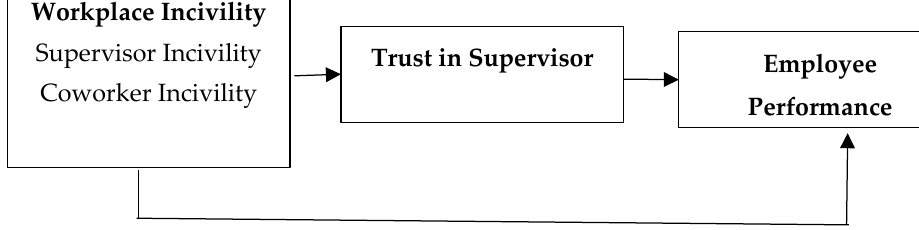
Figure 1. The research framework.